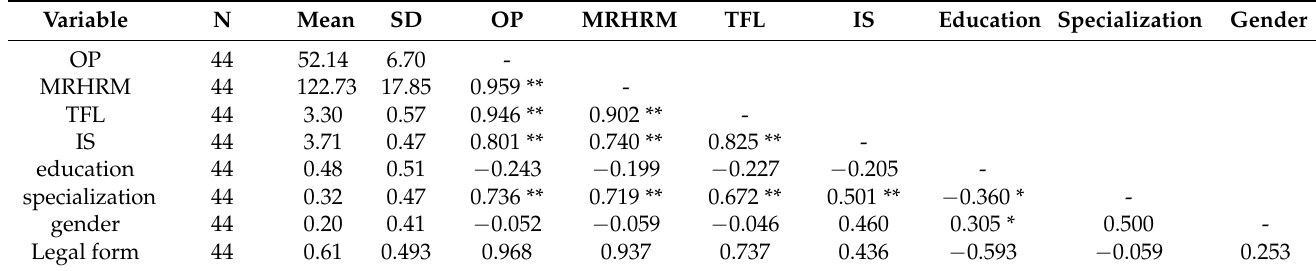
Table 1. Descriptive statistics of variables and correlation